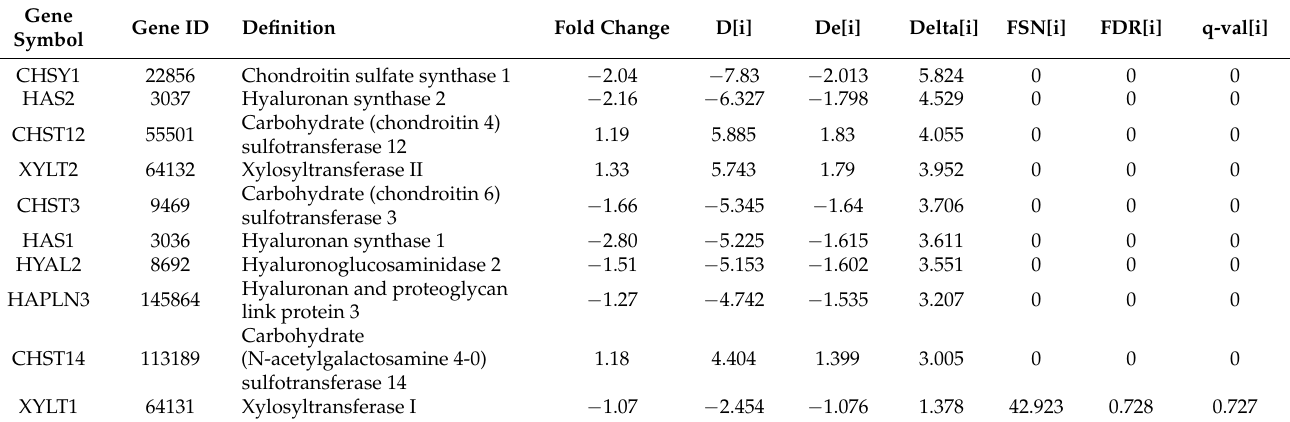
Table 1. GAG enzymes.